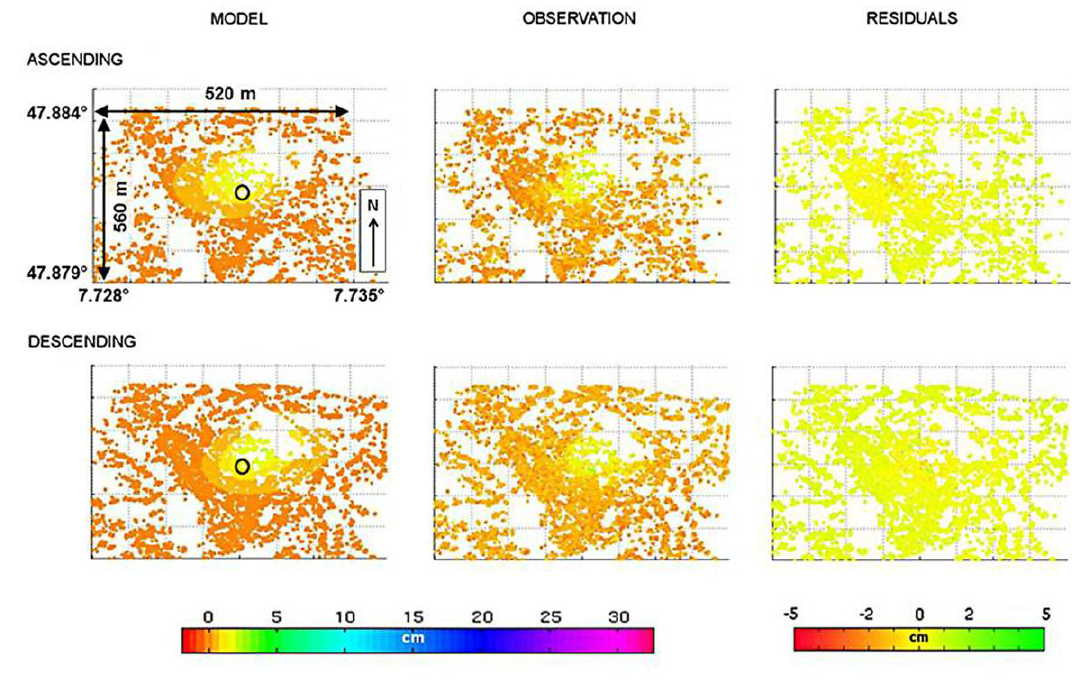
Figure 5. Modeled surface displacements (first column), observed line of sight (LOS) cumulative displacements (second column) and residuals (third column) from joint inversion of ascending and descending data for the period from 9 October 2012 through 11 July 2013. The black circle in the model-images indicates the location of the drilling